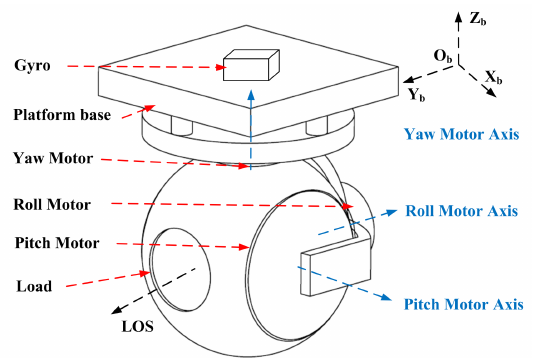
Figure 1. Schematic diagram of a typical three-axis strapdown inertially stabilized platforms (SISP) for